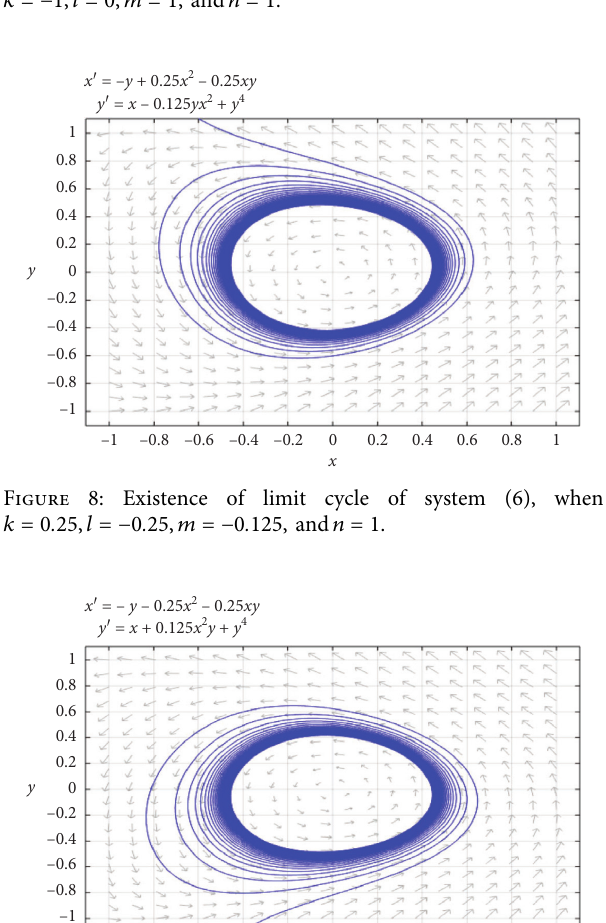
Figure 7: Existence of limit cycle of system (6), when k � − 1 , l � 0 ,m � 1 , and n � 1.